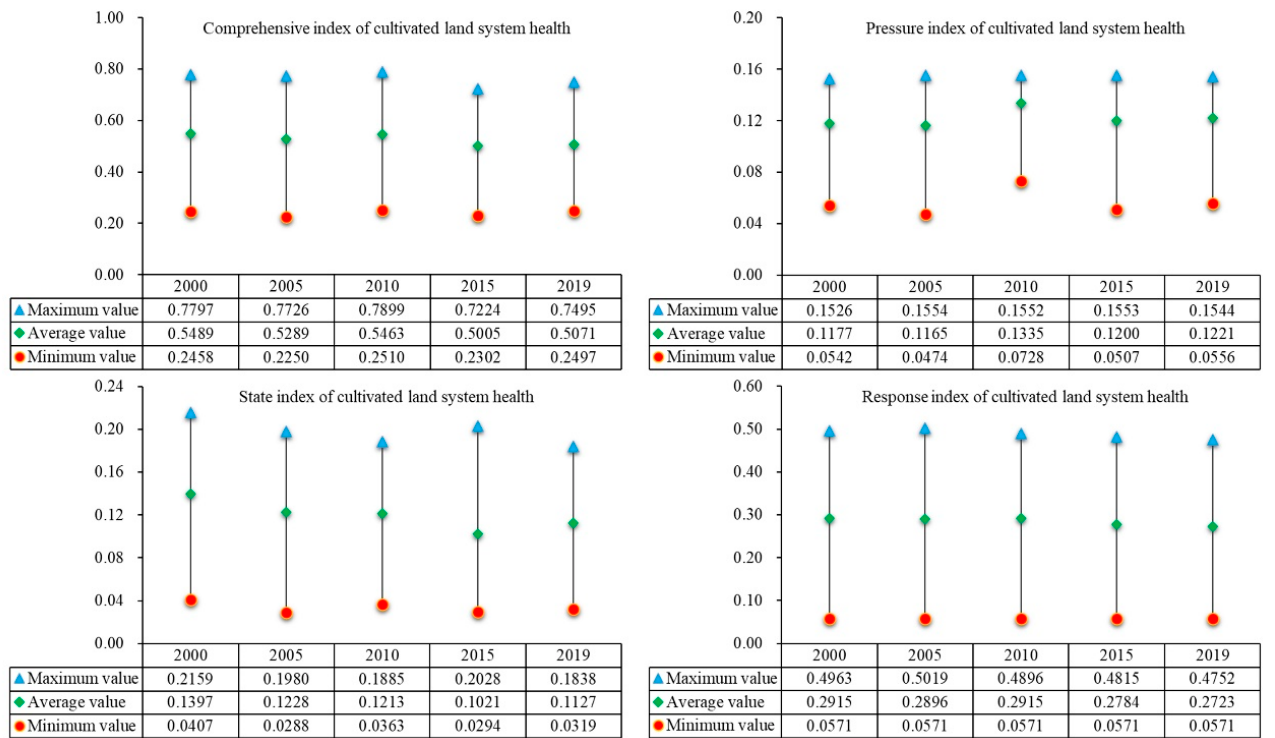
Figure 3. Change characteristics of cultivated land system index in the two lake plains from 2000 to 2019.